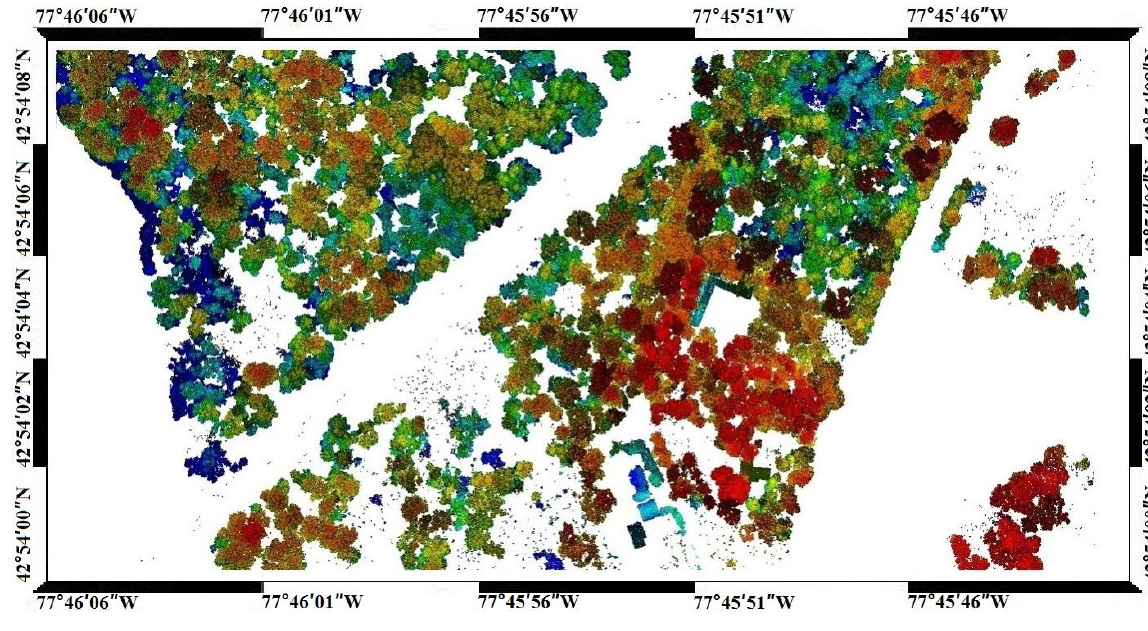
Figure 11. Tall trees point